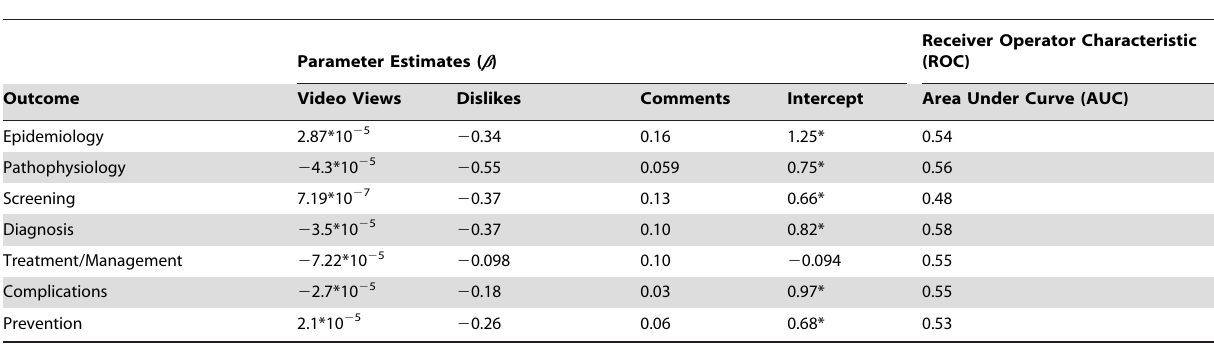
Table 5. Logistic regression and receiver operator characteristics based on user